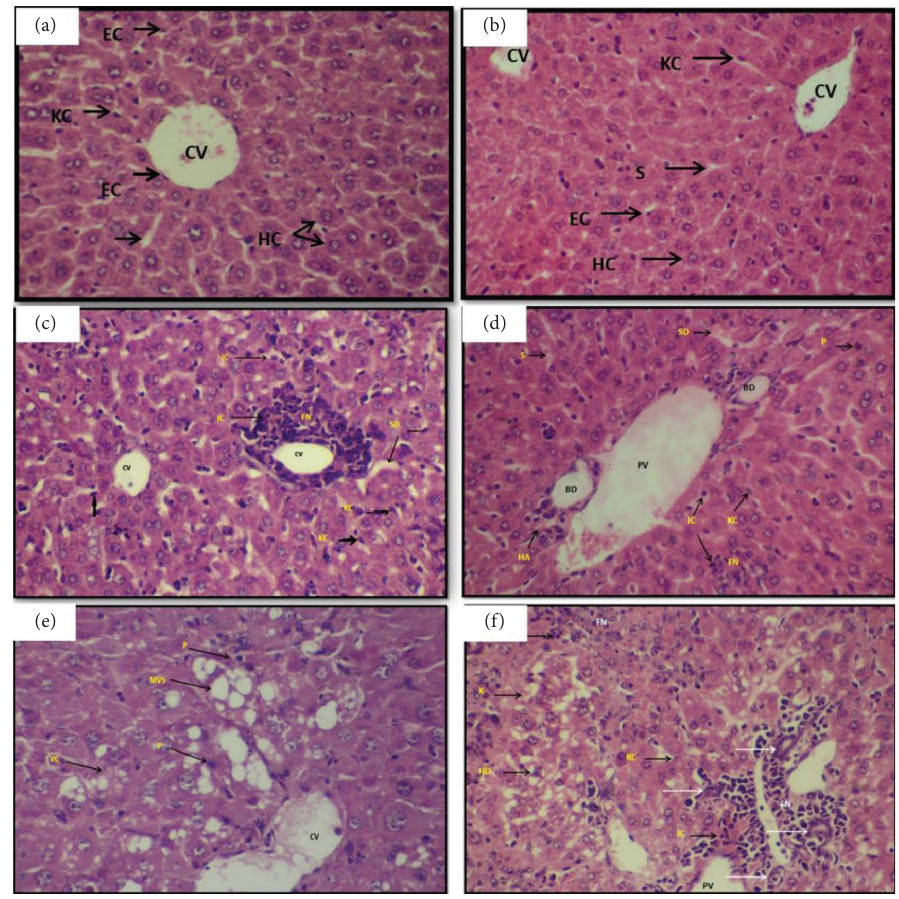
Figure 1: Liver section in mice showing the histopathological changes after exposure to cadmium chloride and/or zinc chloride. (a) Control group showing the normal tissue architecture, (b) treated with ZnCl 2 10mg/k showing almost the normal structure cell, (c) treated with CdCl 2 1.5mg/k, (d) treated with ZnCl 2 10+CdCl 2 1.5mg/k, (e) treated with CdCl 2 3 mg/k, and (f) treated with ZnCl 2 10+CdCl 2 3mg/k showing the central vein (CV), focal necrosis (FN), infammatory cell (IC) infltration, sinusoid dilation (SD), Kupfer cell(KC), signet ring cell (RC), portal vein (PV), bile duct (BD), hepatic artery (HA), sinusoide (S), pyknosis (P), macrovesicular steatosis (MVS), vacuolated cytoplasm (VC), karyolysis (K), hydropic degeneration (HD), and bile duct (BD). H&E stain, 40x. Table 1: Ki-67 proliferation protein percentage in mice hepatocytes exposed to cadmium and zinc chloride calculated using ImageJ